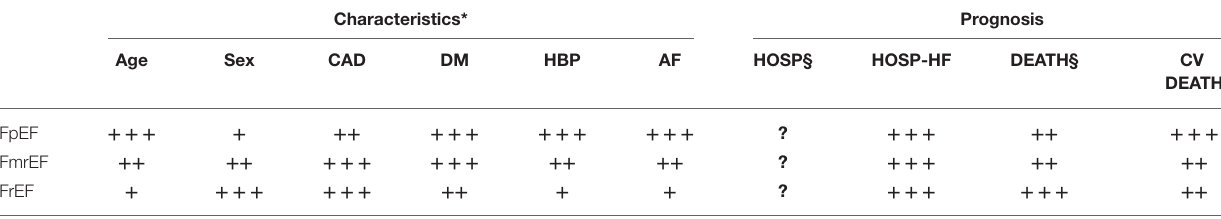
TABLE 1 | Comparisons of clinical characteristics among the different phenotypes of HF.